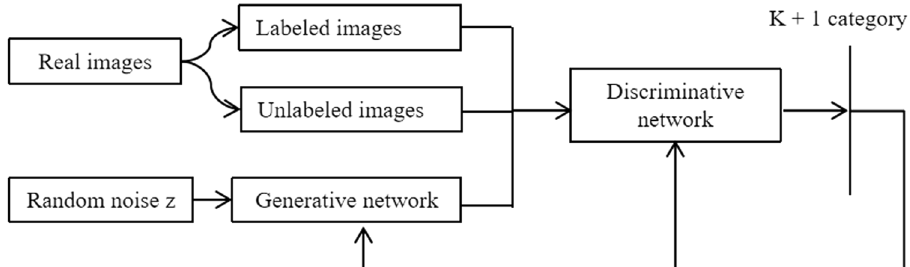
Fig. 1 The network framework of semi-supervised classifica- tion using